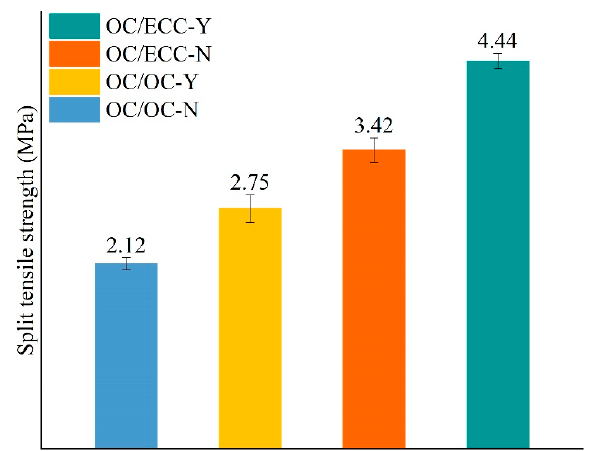
Figure 14. Split tensile strength of each group.